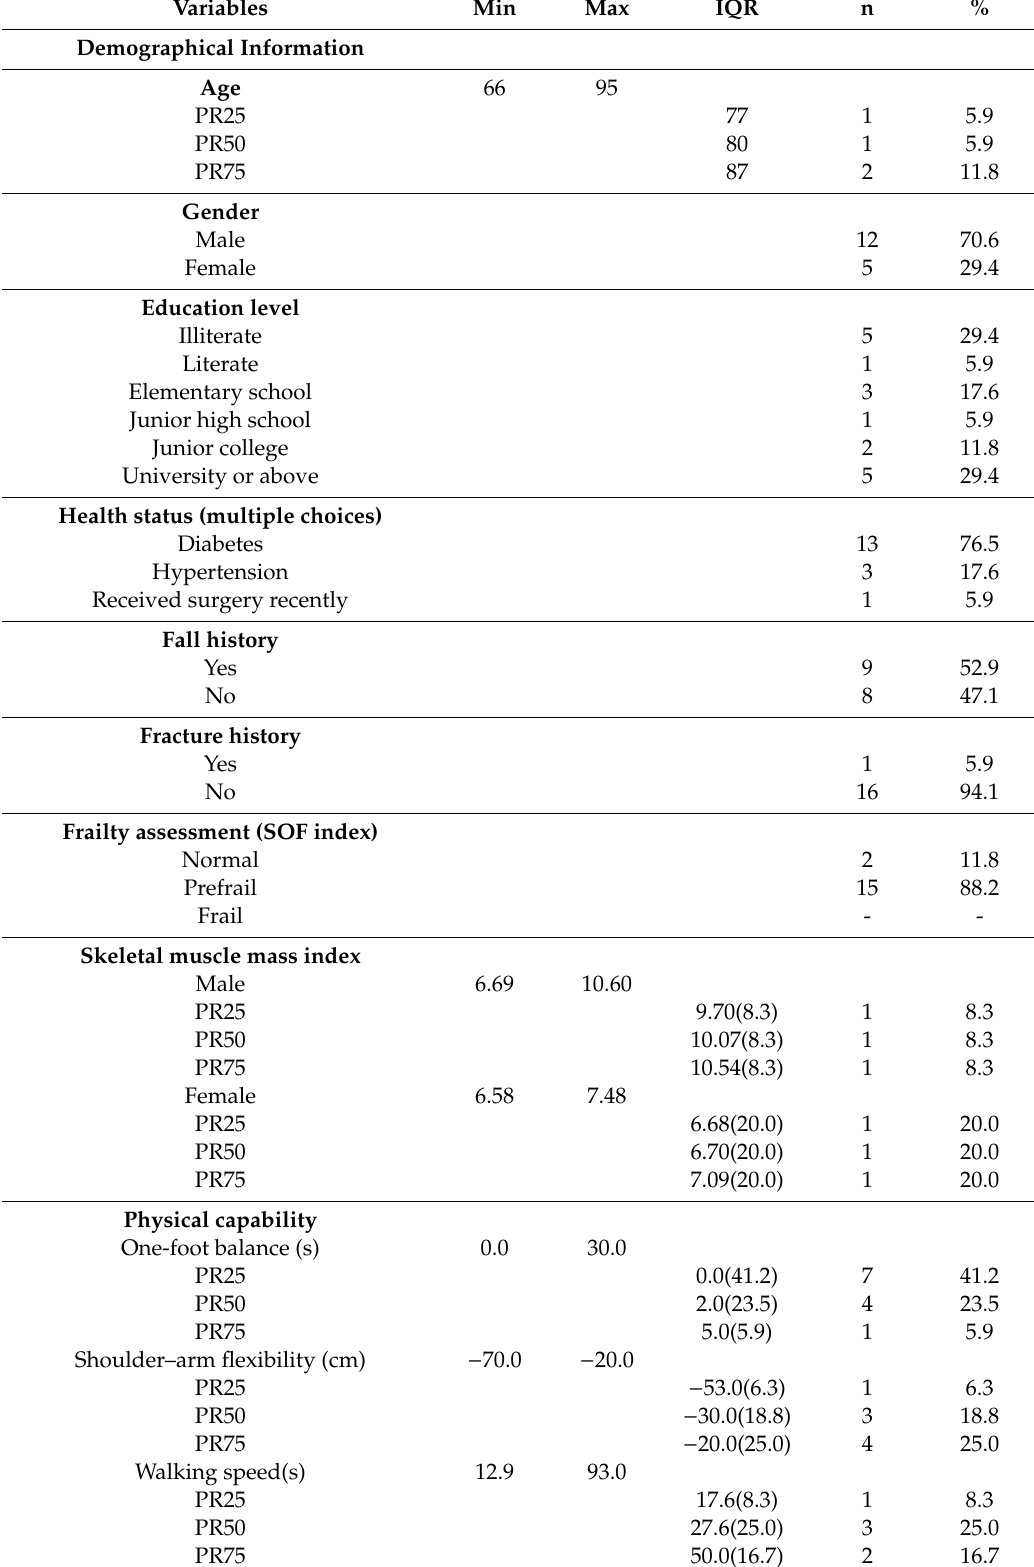
Table 2. Demographic information, physical capability, activities of daily living (ADL), and sleep quality of research participants (n =